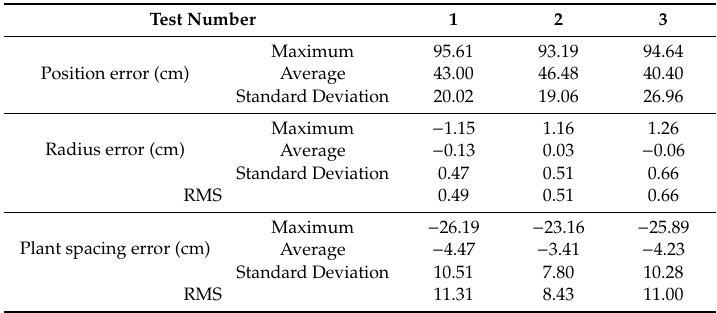
Figure 15. The geometric feature map of the